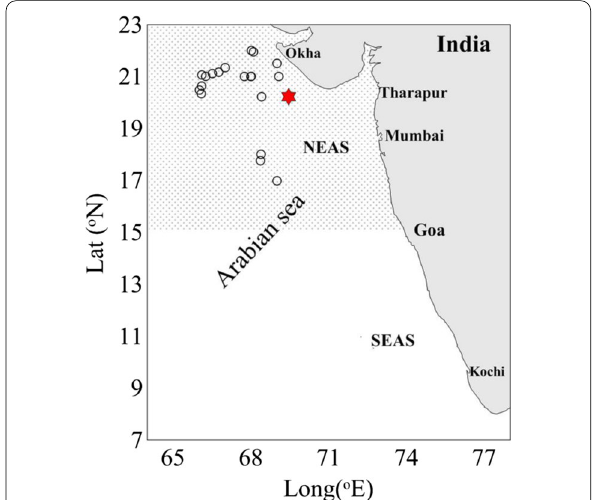
Fig. 1 Study area. Red dot represents the station from where the apostome ciliate Vampyrophrya pelagica was found in